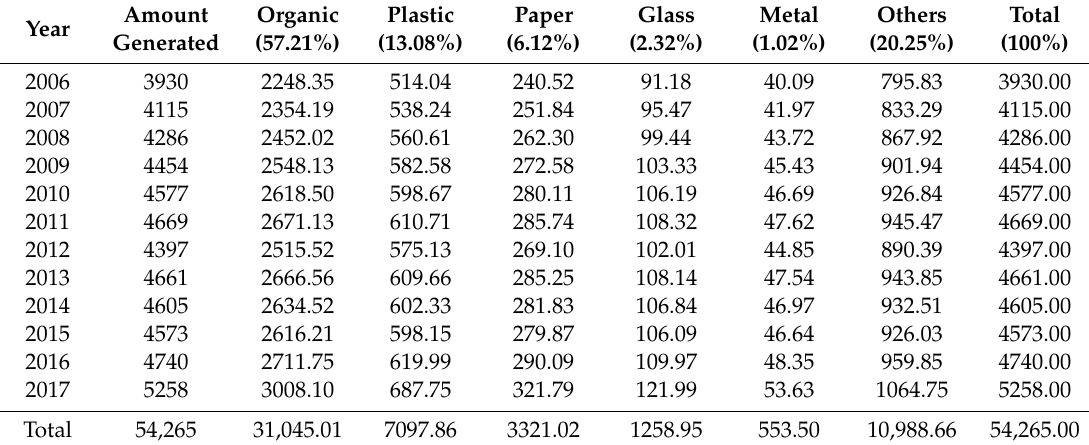
Table 4. Average municipal solid waste generated in Dar es Salaam and composition by waste stream from 2006–2017 (MT / day).